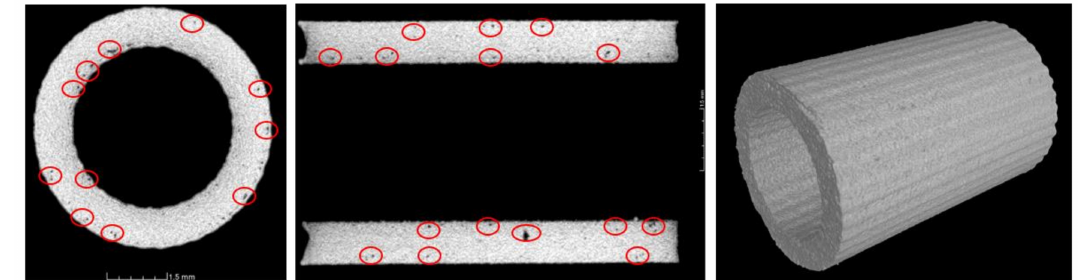
Figure 10. Example CT images of the cylindrical tube specimens.